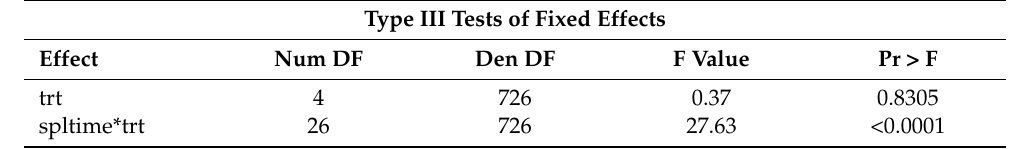
Table A2. Test of Fixed Effects for early seedling